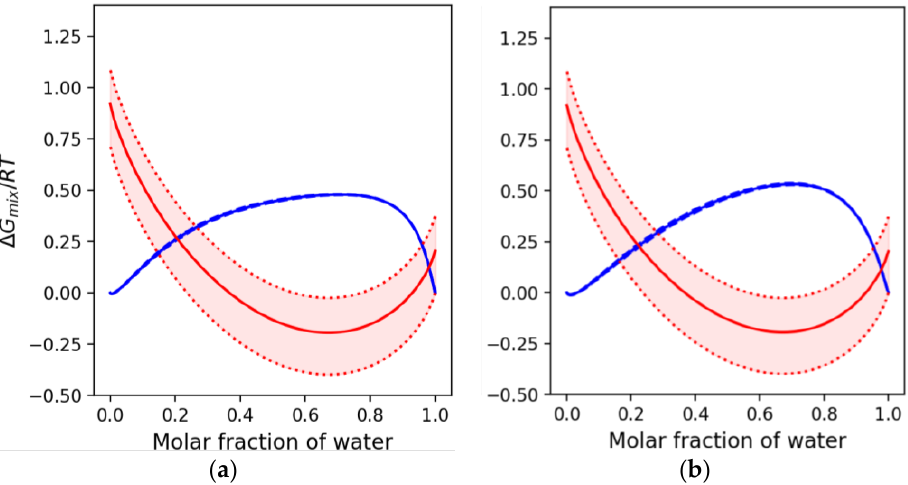
Figure 12. ∆ G mix /RT at 80 ◦ C Using a NRTL Model and Experimental P mix. ( a ) NRTL Klauck et al. [30] parameters and ( b ) NRTL with Aspen Plus V9 parameters. Notes: (i) Red bands represent the experimental ∆ G mix /RT uncertainty for the vapor phase, (i) Thick blue line includes the experimental ∆ G mix /RT for the liquid phases. Parameters reprinted with permission from Klauck, M.; Grenner, A.; Schmelzer, J. Liquid–liquid(–liquid) equilibria in ternary systems of water + cyclohexylamine + aromatic hydrocarbon (toluene or propylbenzene) or aliphatic hydrocarbon (heptane or octane). J. Chem. Eng. Data, 2006, 51 , 1043–1050, doi:10.1021/je050520f. Copyright 2021 American Chemical